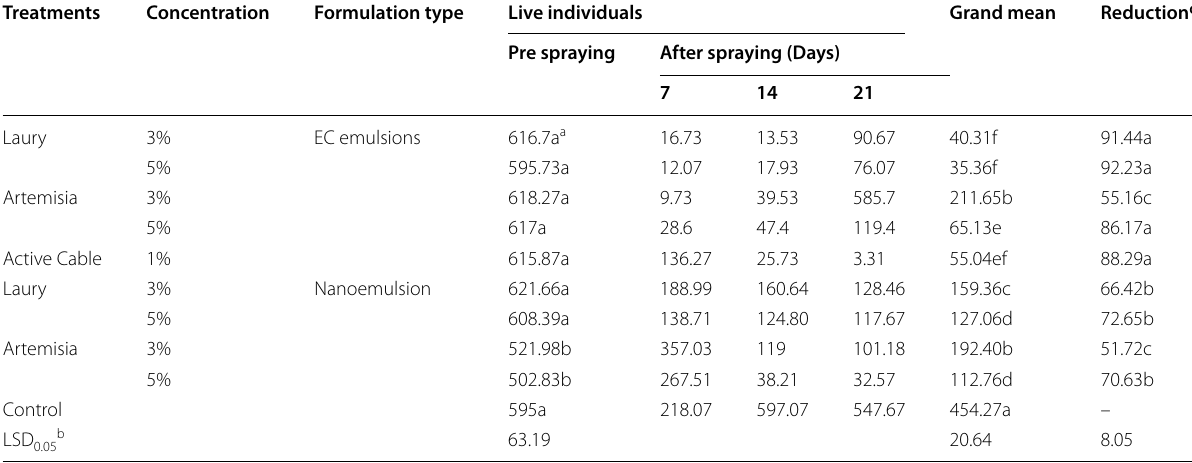
Table 5 Insect nymphs of Parlatoria ziziphi affected by application of two formulation types based on the plant essential oils in citrus orchards